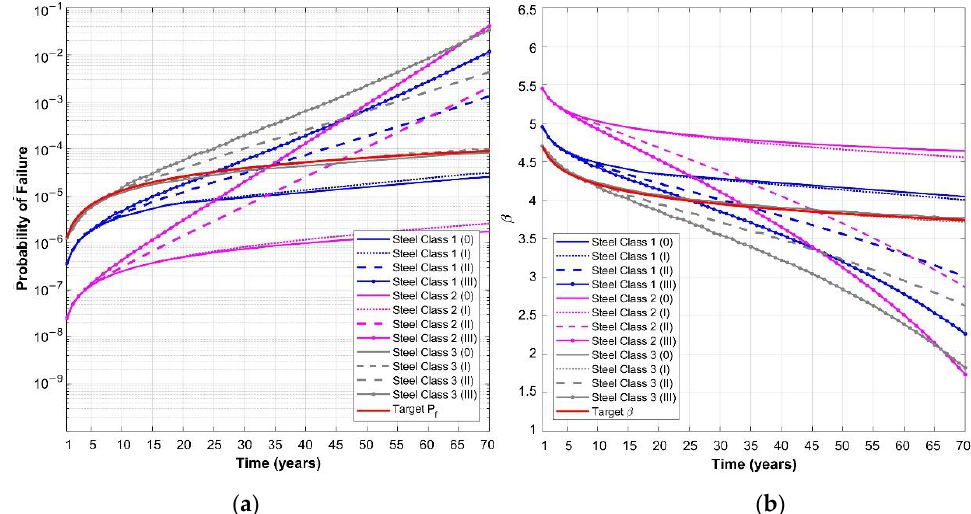
Figure 10. Time-dependent probability of failure ( a ) and reliability index 𝛽 ( b ) for shopping buildings (concrete class 3).